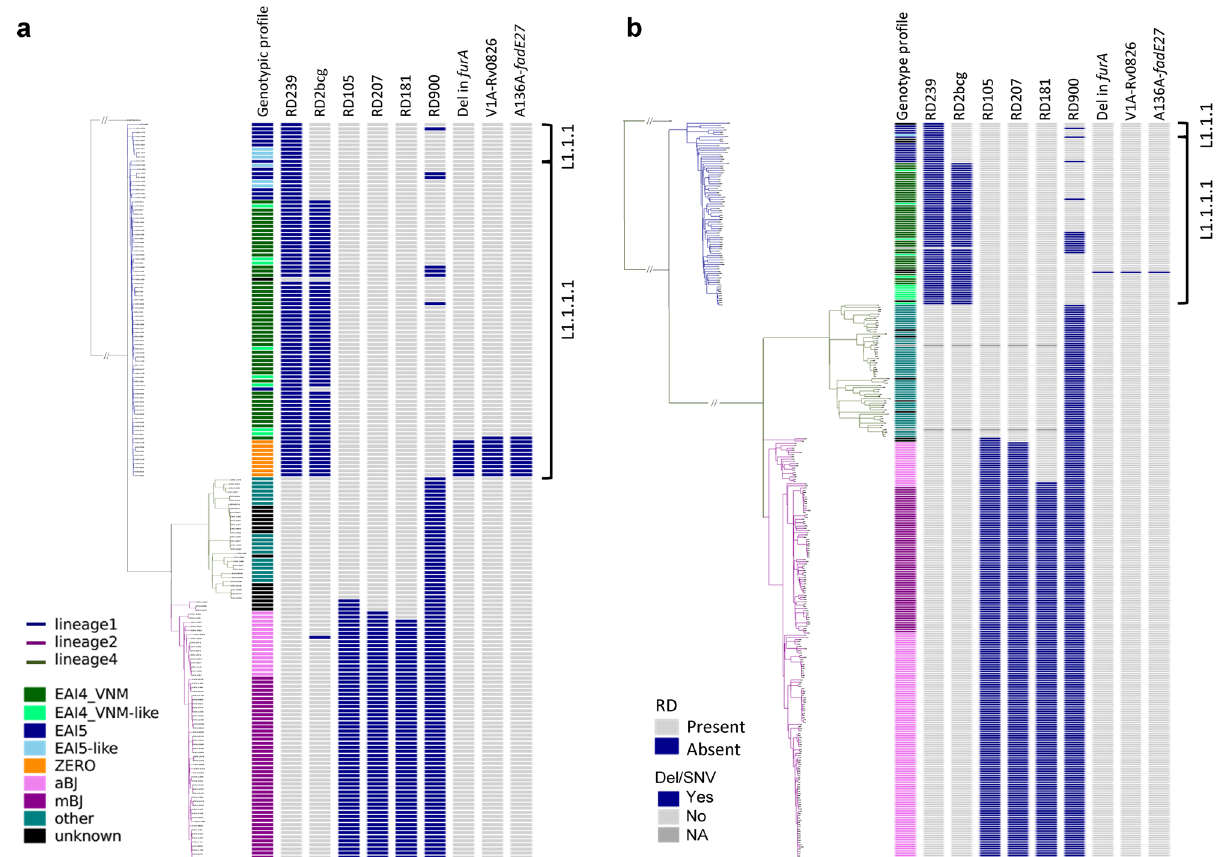
Figure 1. Phylogenetic tree of 181 Da Nang strains ( a ) and 332 Hanoi strains (the northern Vietnam data set) ( b ), constructed using variants after mapping with H37Rv. Phylogenetic trees were constructed with the maximum likelihood method using RAxML version 8.2.8 (https:// github. com/ stama tak/ stand ard- RAxML) and visualized with plotTree for python v2.7 (https:// github. com/ katho lt/ plotT ree). Regions of difference (RDs), deletions, and SNVs in correlation with Mtb clades are depicted. Mtb Mycobacterium tuberculosis , SNV single nucleotide variant, Del deletion, aBJ ancient Beijing, mBJ modern Beijing, NA not